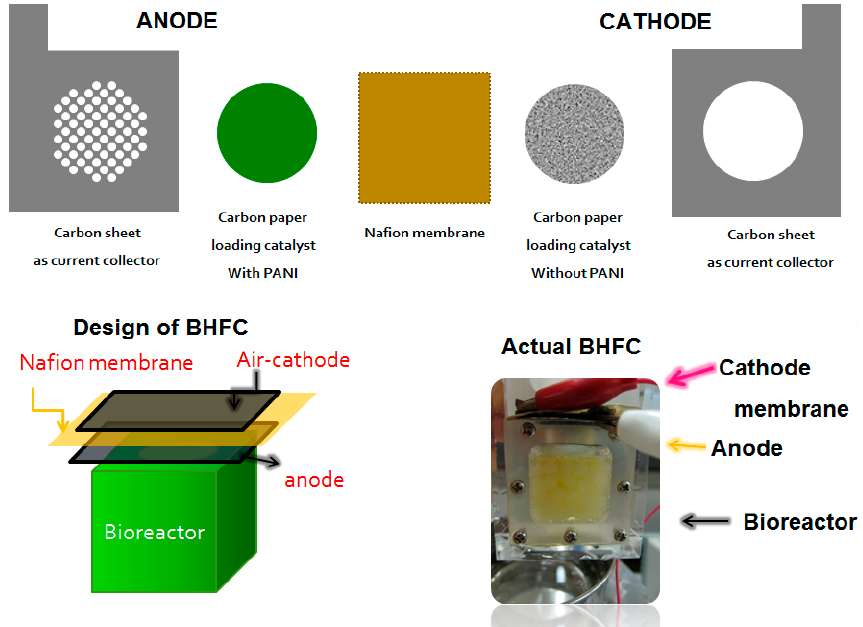
Figure 9. Fuel cell components and the assembly of hydrogen fuel cell with bioreactor.